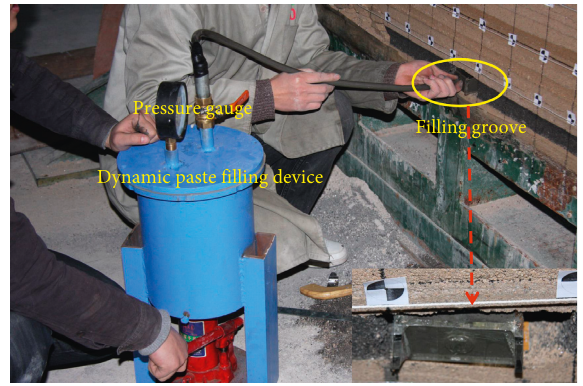
Figure 8: Filling mining